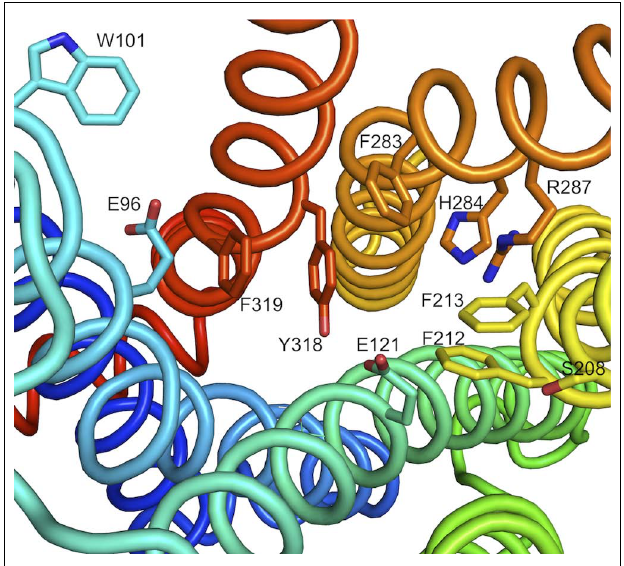
FIGURE 2 |A model of the Helicoverpa zea PBAN-receptor illustrating amino acids that could be involved in binding PBAN. Reproduced with permission from Jurenka and Nusawardani (2011).